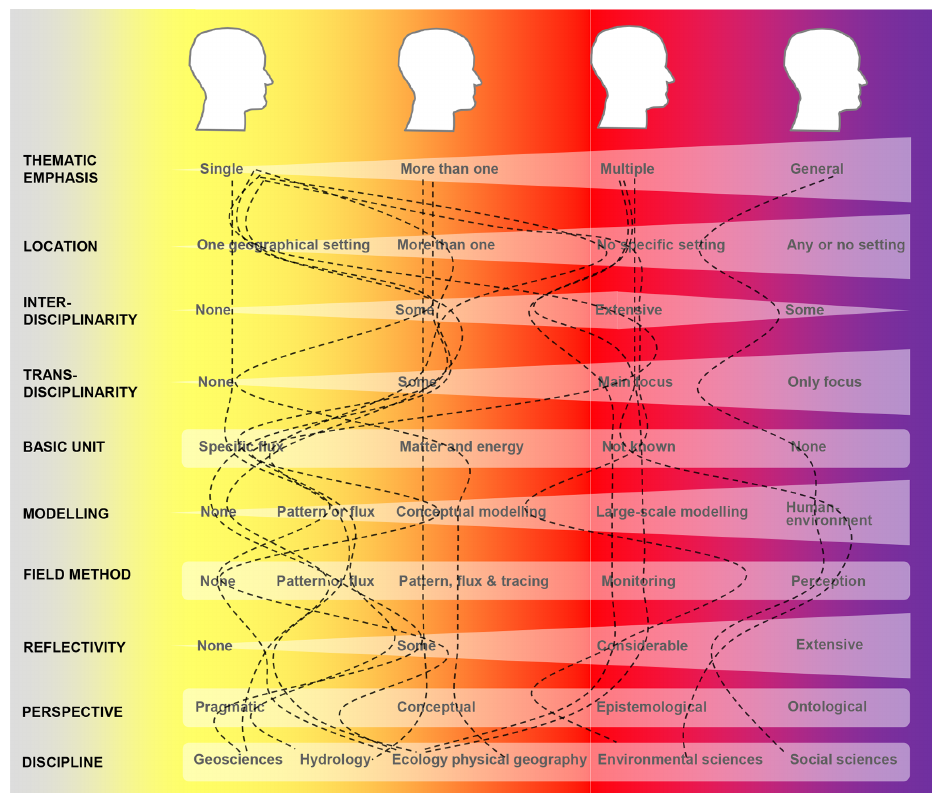
Figure 3. Individual mental model profiles of 13 scientists active in connectivity research. Individual mental model profiles (lines) plotted against elicited attributes of four stylised research perspectives (pragmatic – yellow; conceptual – orange; epistemological – red; ontological – violet) after Öberg (2011). The representation of interdisciplinarity is two-sided by referring to small-to-extensive interactions between different natural-science disciplines on the left side of the graphic (“None” to “Some”) and between natural and social sciences in the middle and on the right side of the graphic (“Extensive” to